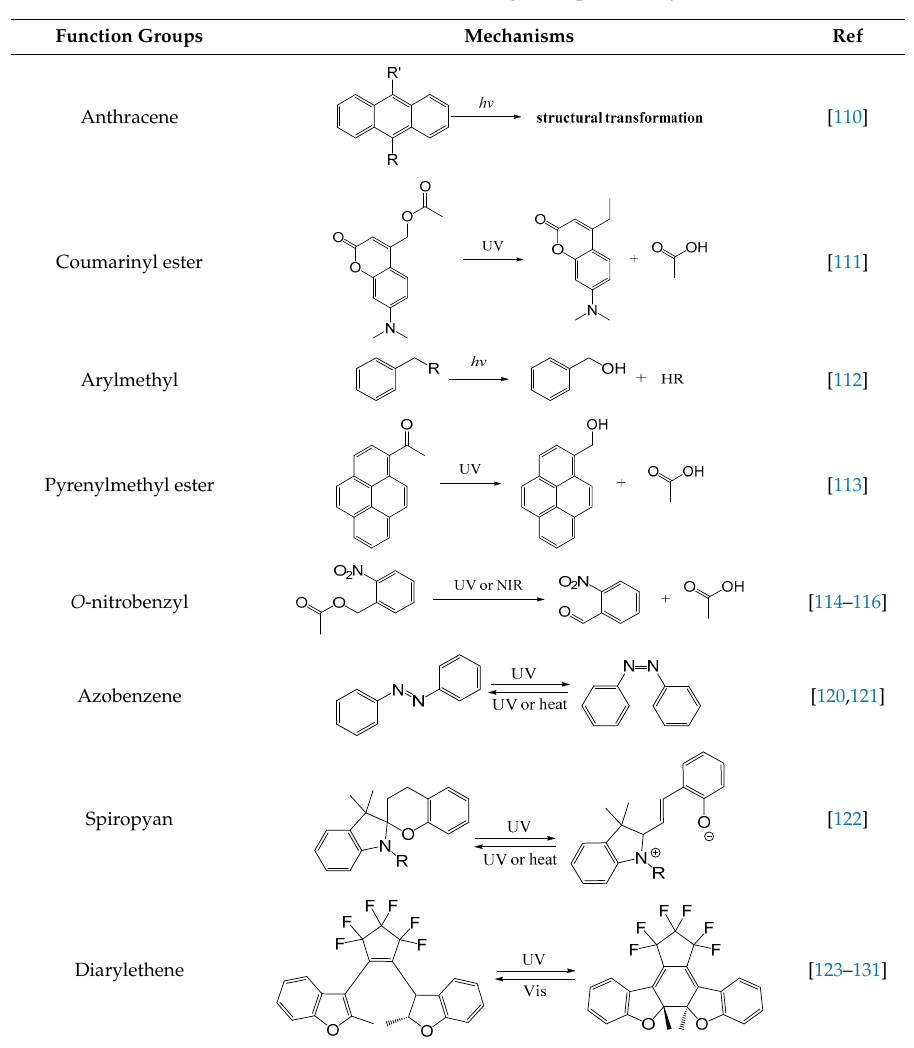
Table 3. Chemical structures for light-responsive systems.